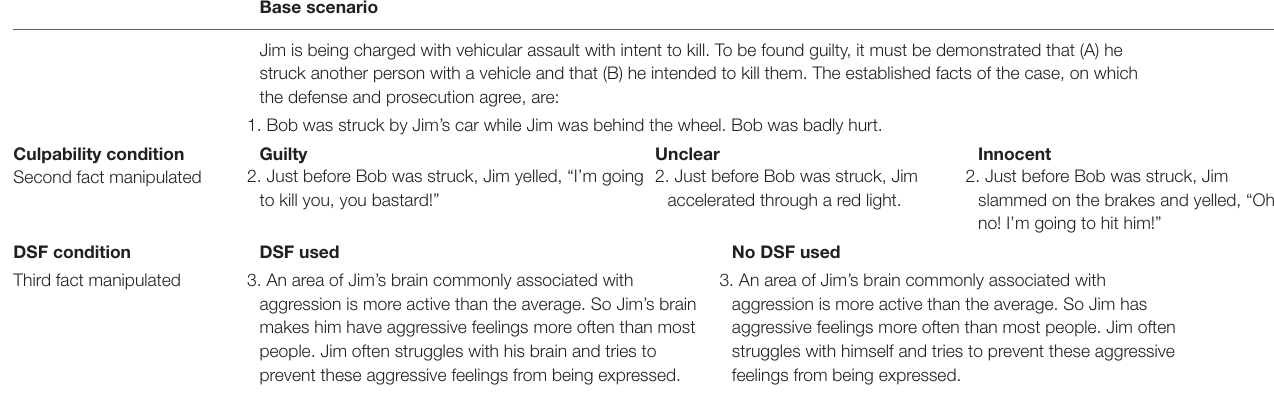
TABLE 1 | Experiments 1 and 3 vignette manipulation by condition. Base